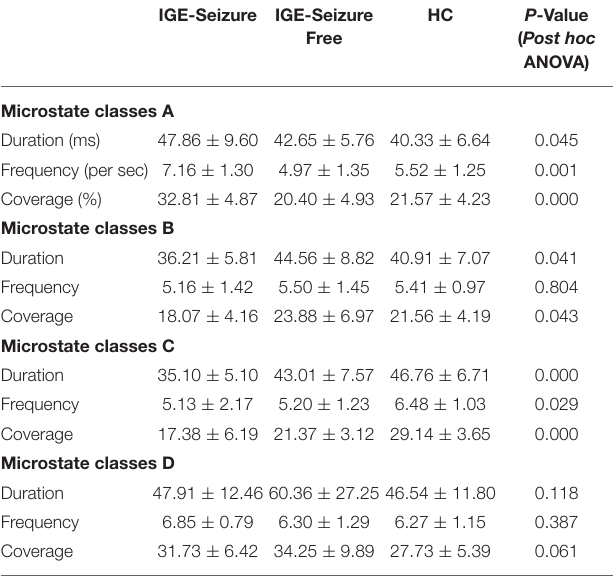
TABLE 2 | Microstate characteristics between the three groups (Mean ±